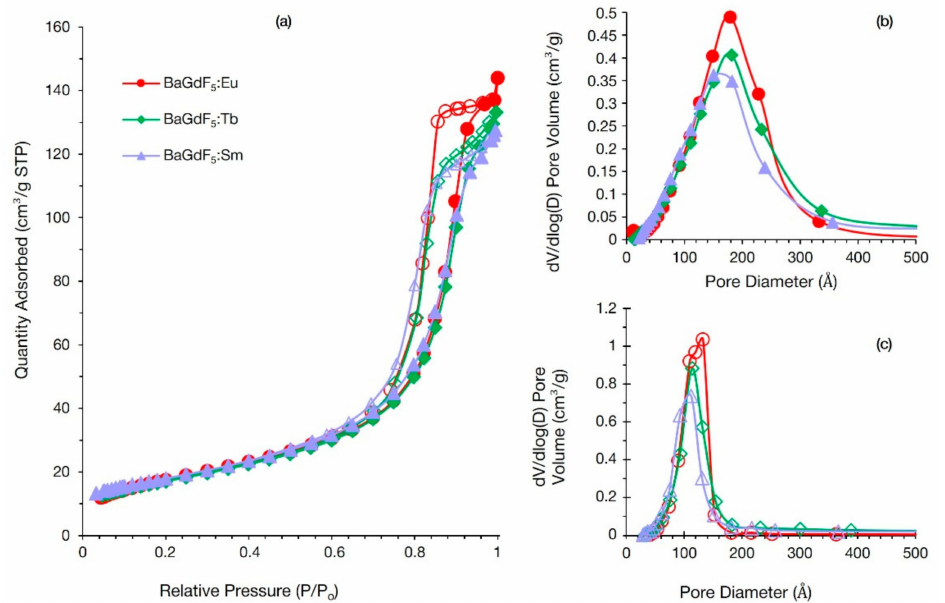
Figure 4. ( a ) Nitrogen sorption isotherms of synthesized samples BaGdF 5 :Eu (circle markers), BaGdF 5 :Tb (diamond markers), and BaGdF 5 :Sm (triangle markers). Adsorption branches of isotherms pointed with filled markers, while desorption ones—empty markers. BJH adsorption pore distribution obtained from the N 2 adsorption isotherms ( b ). Panel ( c ) as panel ( b ) from the desorption